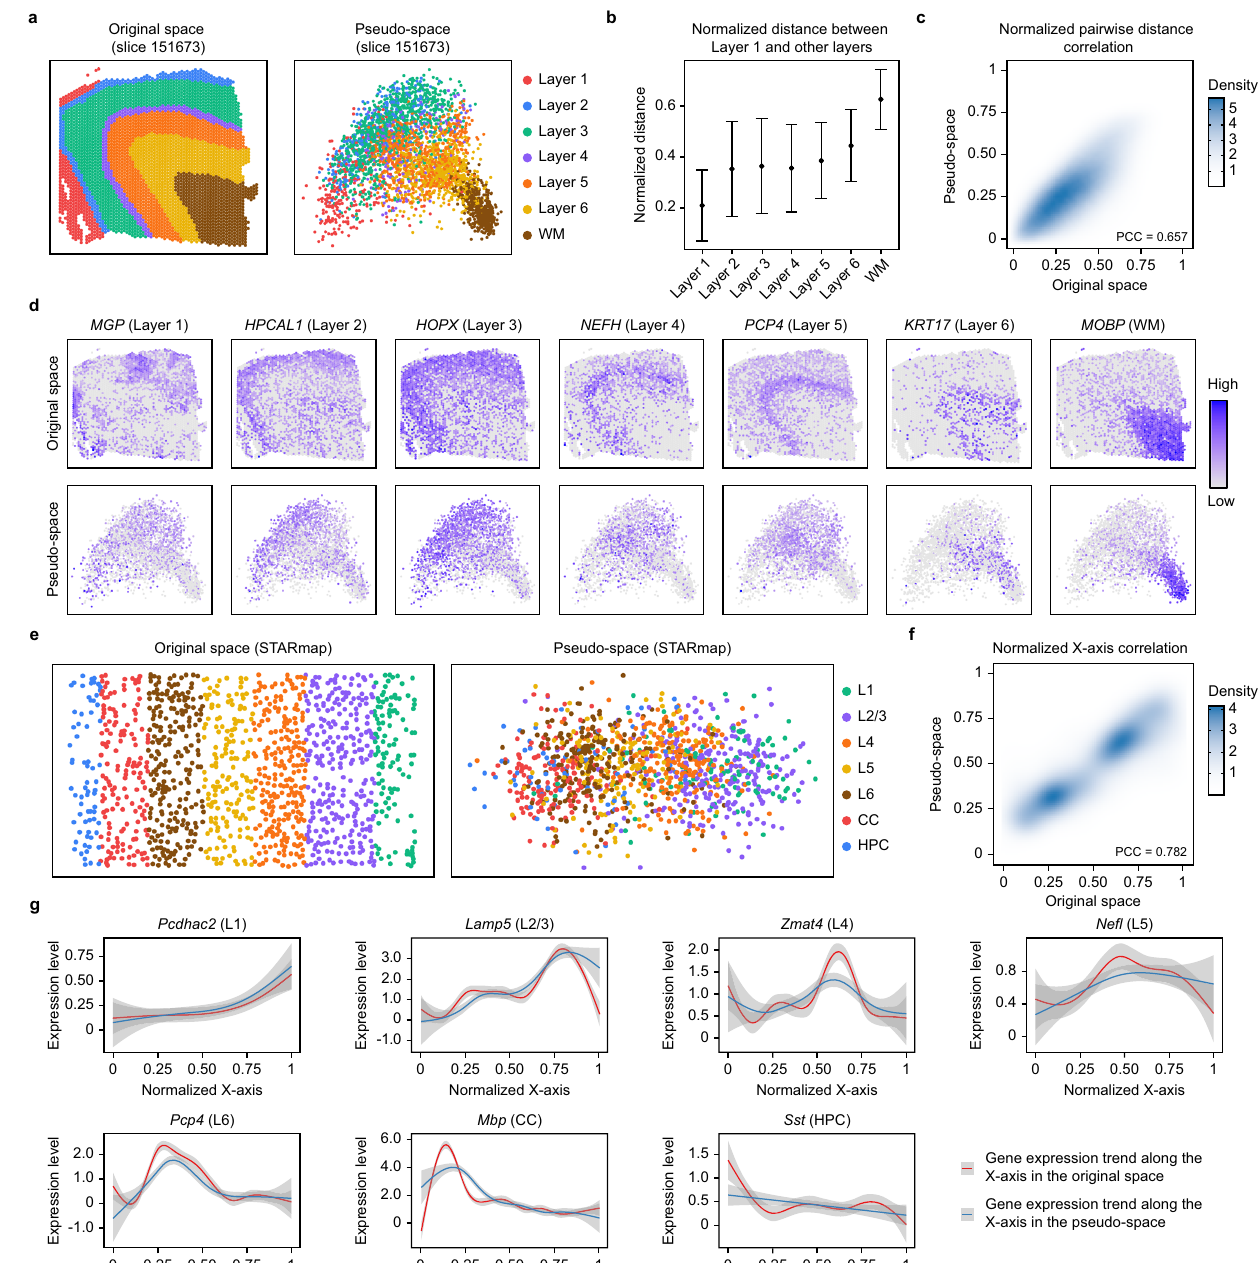
Fig.2|ReconstructingthehierarchicalstructureofbraincortexusingSTdata. a Theoriginalspace(left)andreconstructedpseudo-space(right)ofhumanDLPFC layersofslice151673. b Normalizedpairwisedistancebetweenspotsfromdifferent layerstoLayer1.Dataarepresentedasthemedian±SD.Thenumberofdatapoints for the error bars from left to right are 37,401, 69,069, 269,997, 59,514, 183,729, 188,916, and 140,049, respectively. c Density plot of the correlation of pairwise distances between spots in the original-space and pseudo-space. d The spatial